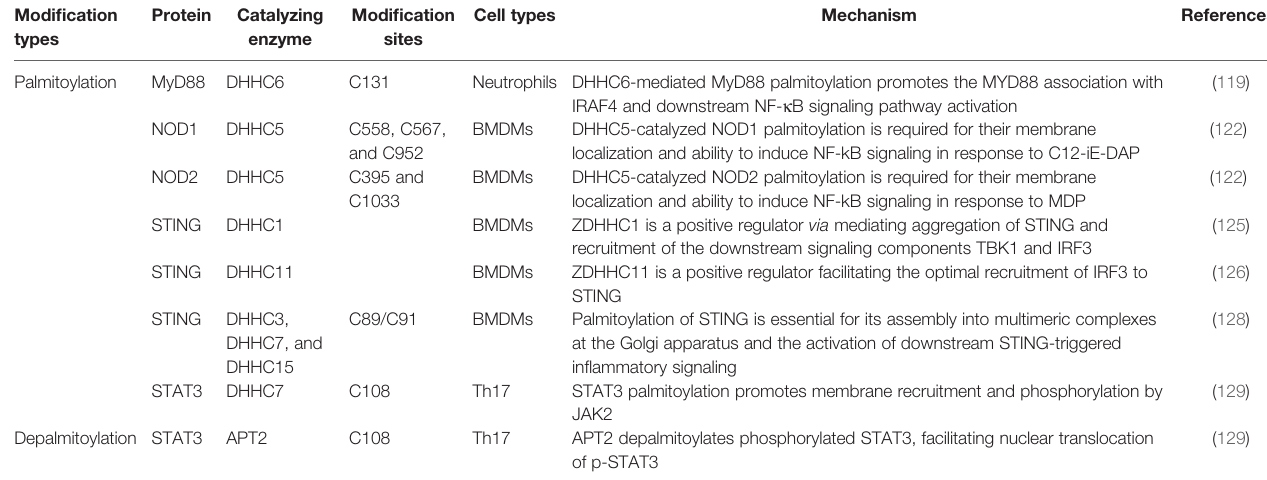
TABLE 2 | Palmitoylation and depalmitoylation related to in fl